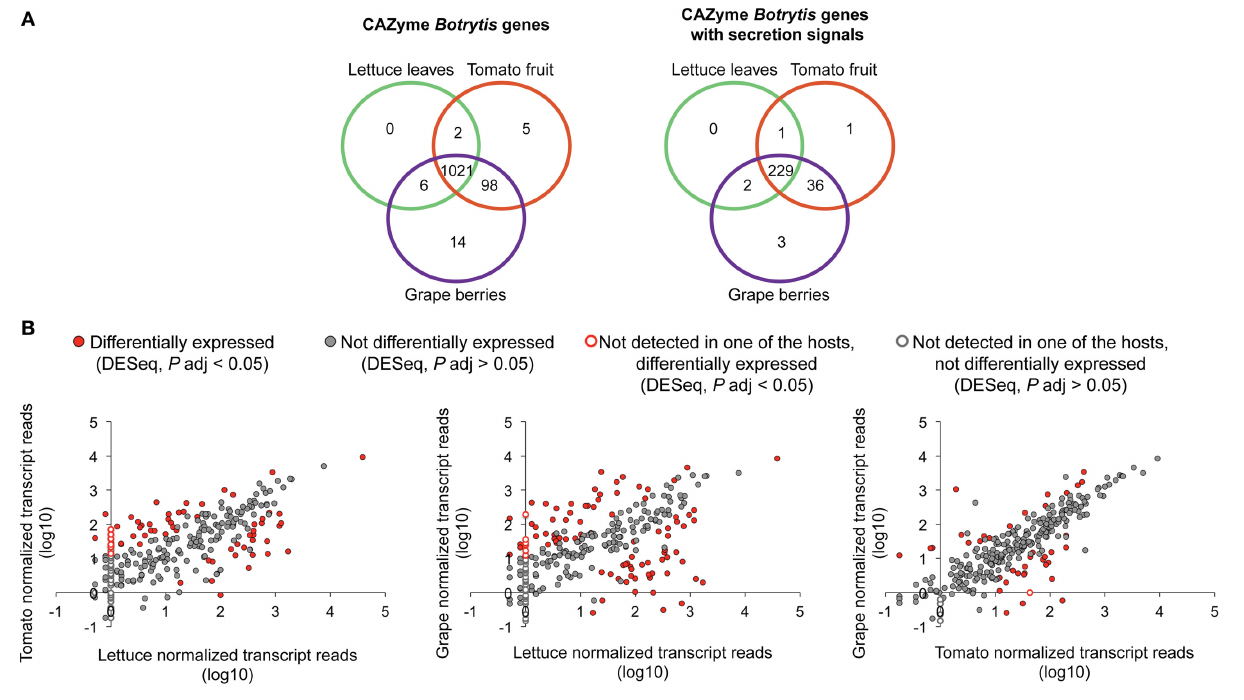
(right) detected in the transcriptomes of the three infected host tissues. (B) Scatterplots showing all possible pair-wise correlations between DESeq-normalized counts of CAZyme Botrytis genes in lettuce, tomato, and grape.